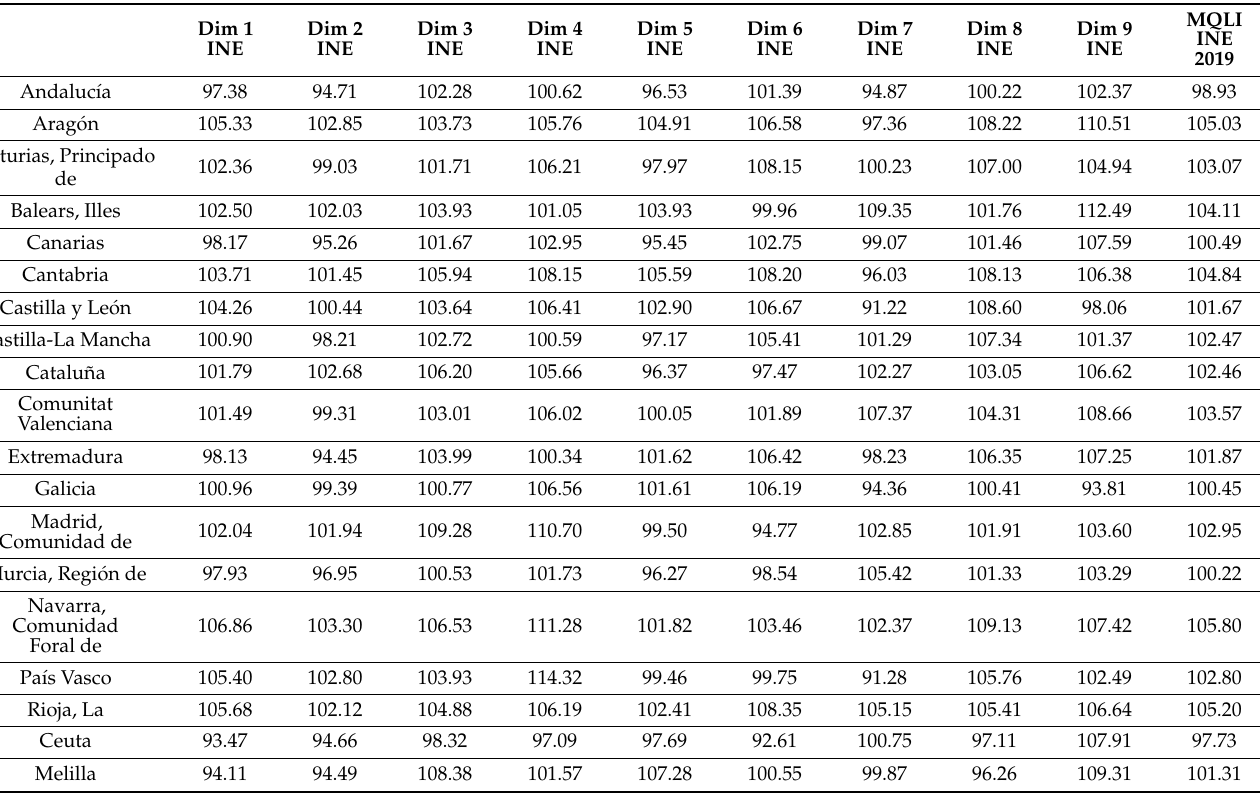
Table 4. Values of the 9 dimensions and the MQLI obtained by INE for the year 2019.